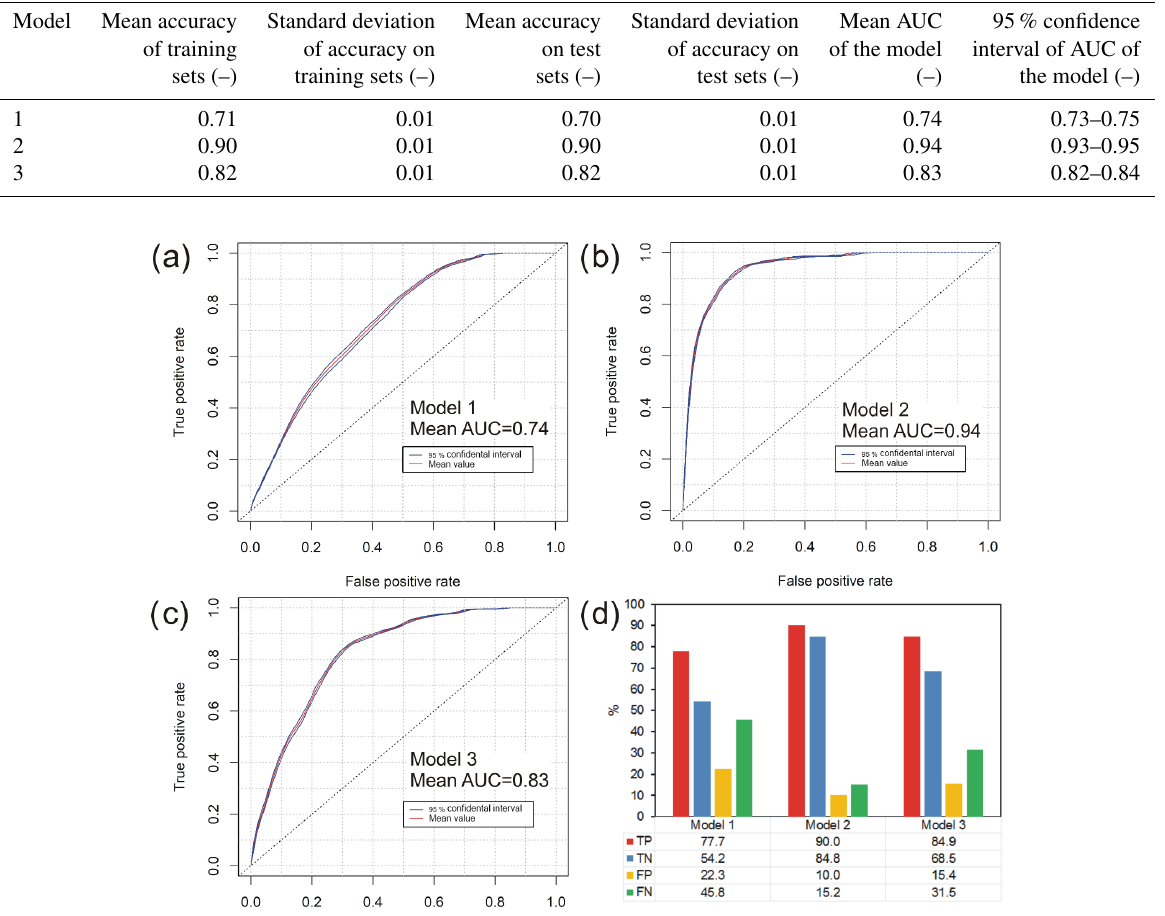
Table 3. Mean and standard deviation of accuracy for the training sets, the test sets and the final application of the model to the entire study area.